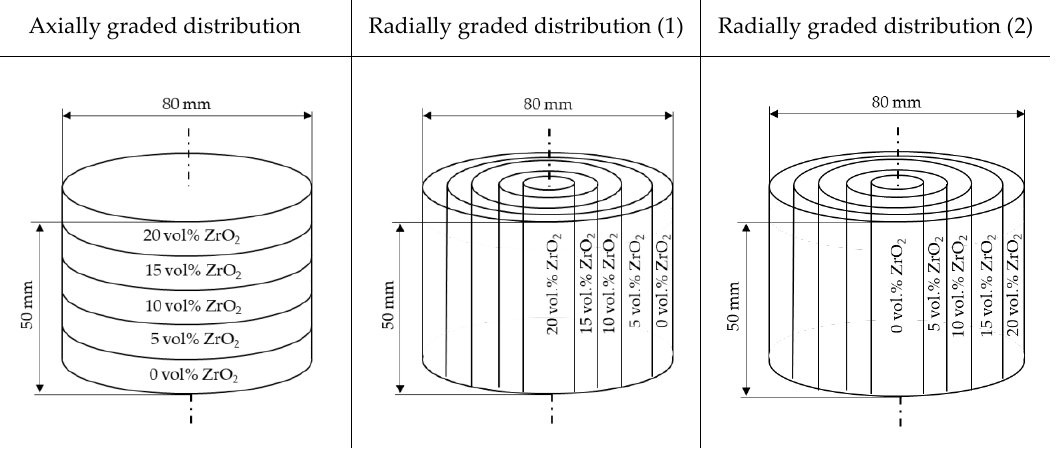
Figure 1. Types of specimens fabricated.